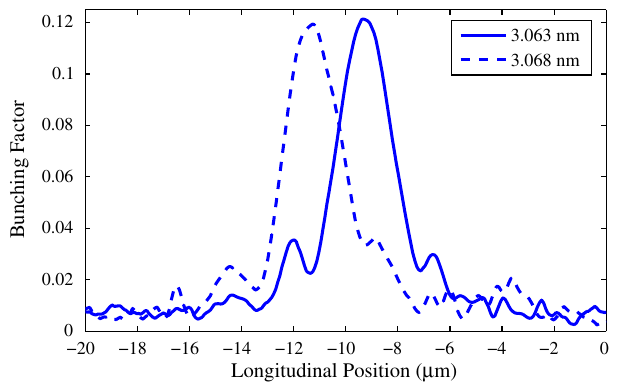
FIG. 6. Bunching factor at two wavelengths with 0.15% band- width from ELEGANT [16] simulation (parameters in Table I). effects (e.g. emittance and T 566 ), ISR and finite laser radius.